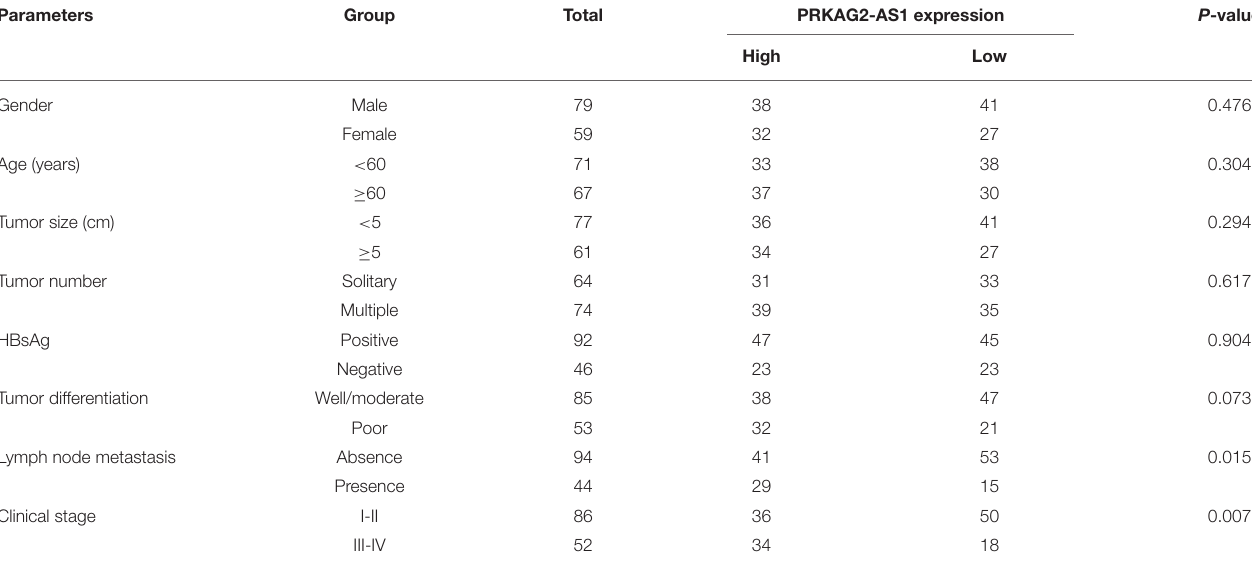
TABLE 2 | Association of PRKAG2-AS1 expression with clinicopathological characteristics of HCC patients. Parameters